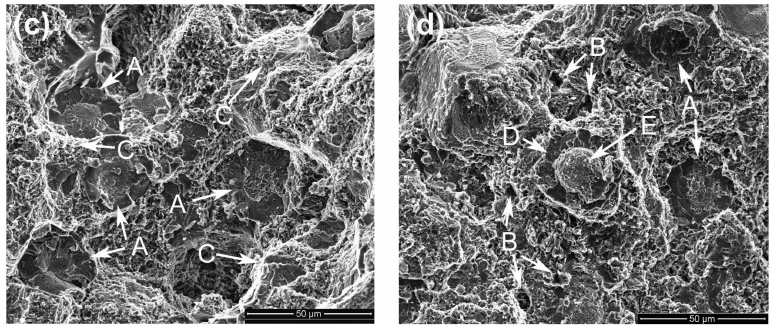
Figure 8. Fractographs of the composites thixoformed at reheating temperatures of ( a ) 590 ◦ C, ( b ) 600 ◦ C, ( c ) 605 ◦ C, and ( d ) 610 ◦